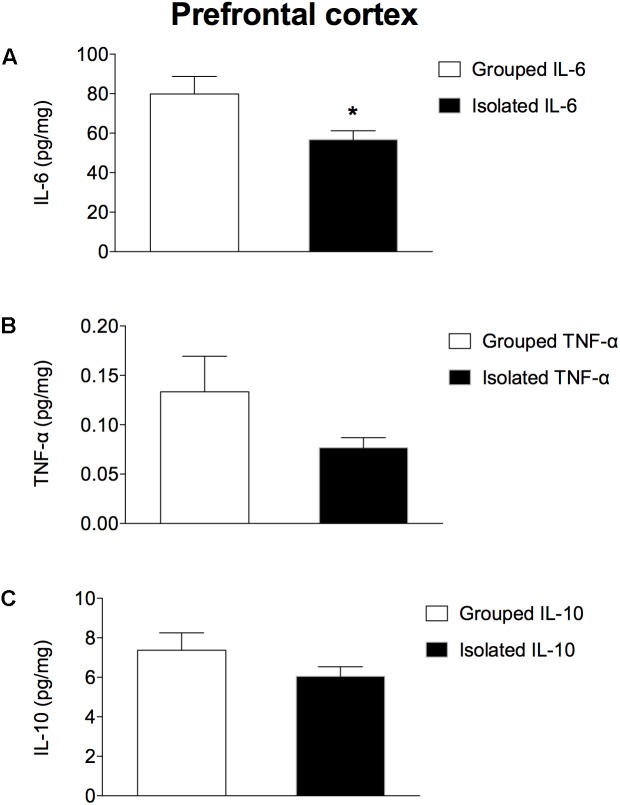
Effect of rearing condition (isolated vs. grouped) on cytokines in the prefrontal cortex of rats exposed to 10 weeks of social isolation. Isolated rats (n = 9) had reduced (A) IL-6, but no difference was found for (B) TNF-α or (C) IL-10 in comparison to grouped rats (n = 9). Data are expressed as mean ± S.E.M and given as pg/mg. ∗p < 0.05 (Student’s t-test) compared to grouped rats.